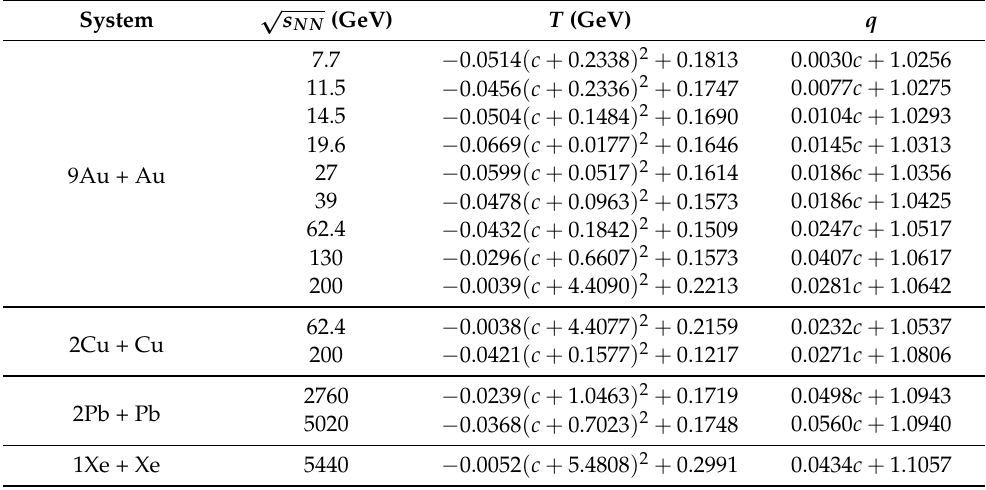
Figure 5. (Color online) Nonextensive parameter q dependence of the temperature divided by the √ s in A + A collisions with different centrality. The curve natural logarithm of collision energy T / ln is the fit results and the fit function is indicated in the legend. Table 1. The fit parameters of T and q as function of centrality c